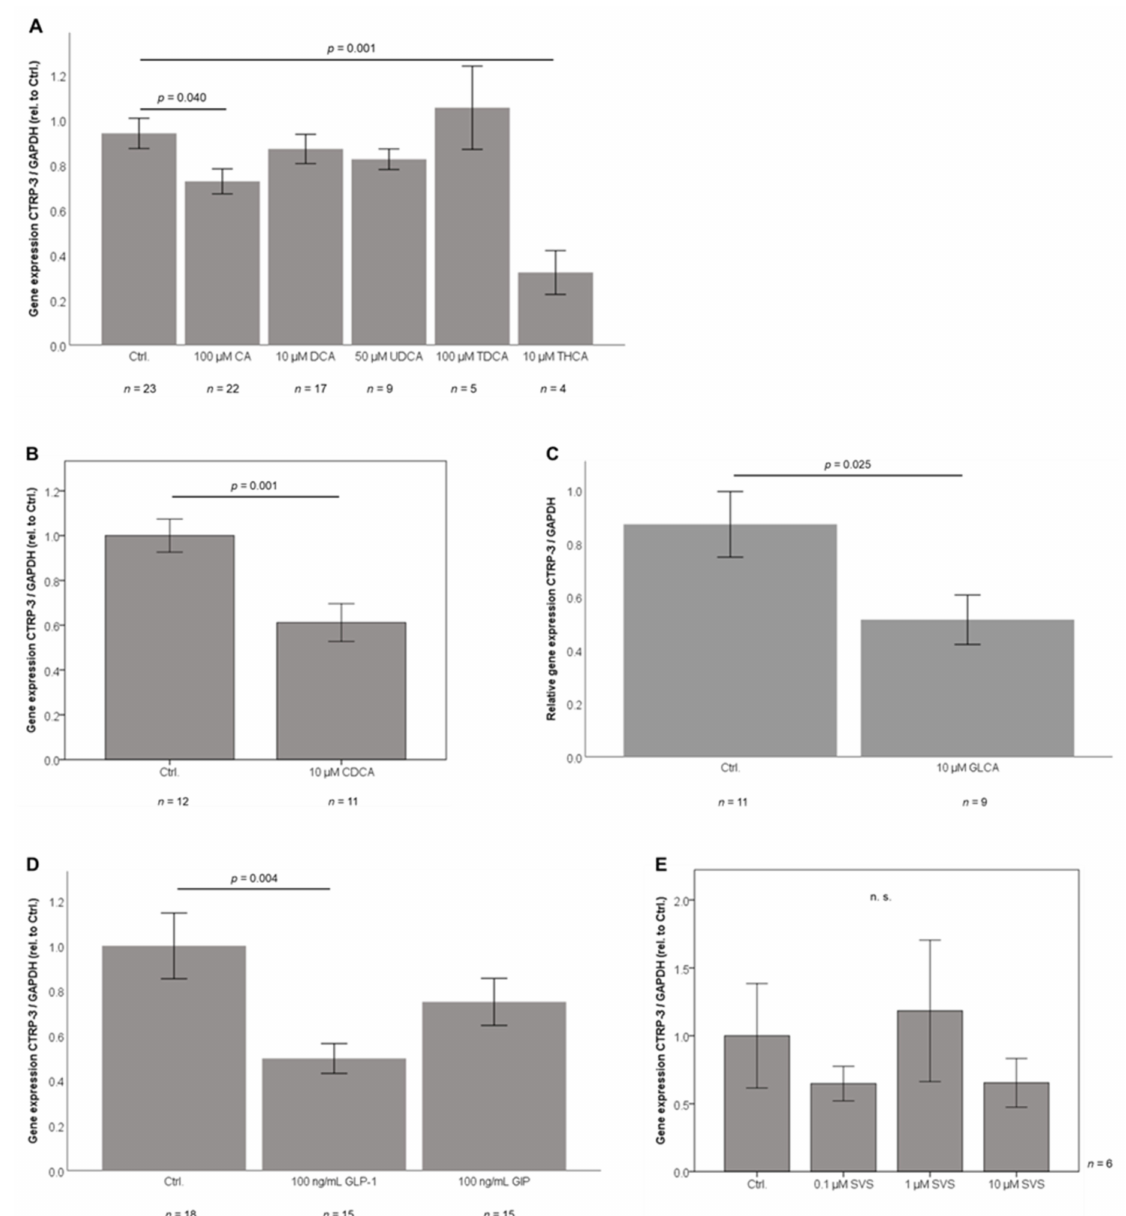
Figure 4. CTRP-3 gene expression is a ff ected by bile acids and incretins in adipocytes in vitro. 3T3-L1 adipocytes were stimulated with bile acids, incretins and the cholesterol inhibitor